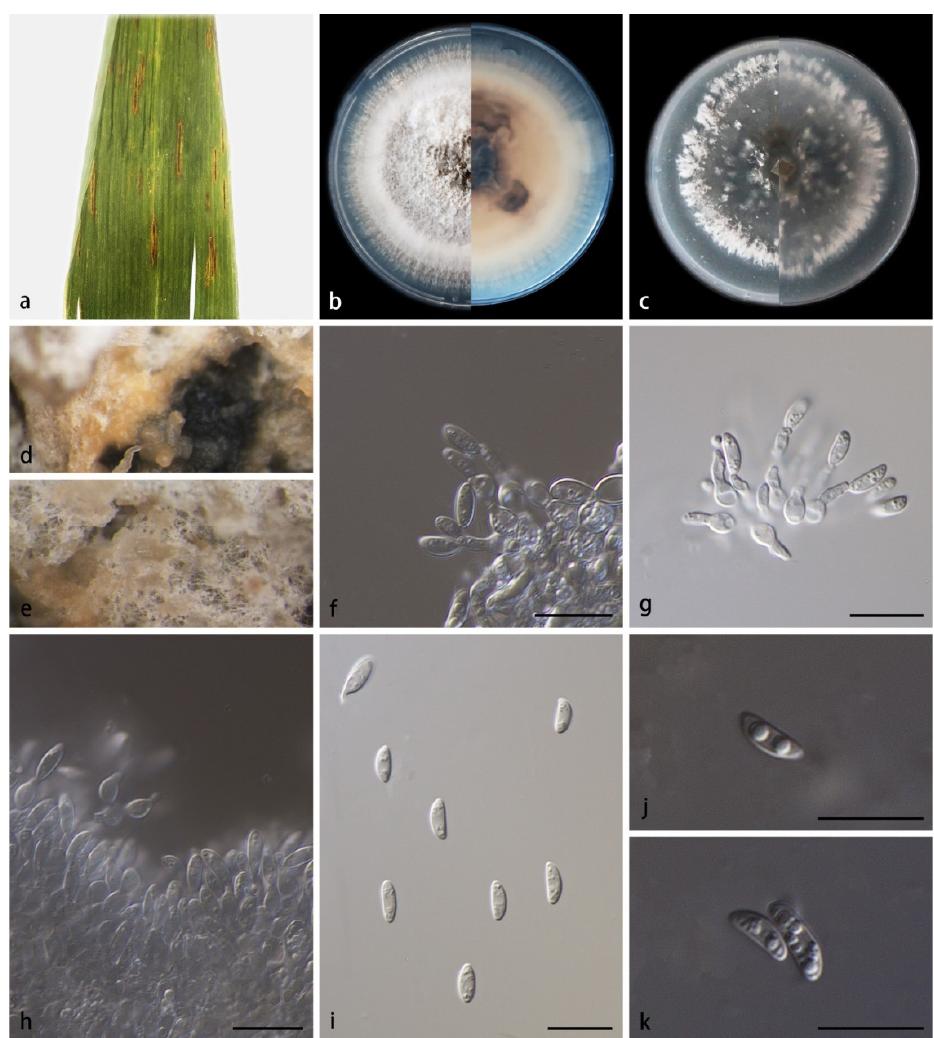
Figure 4. Microdochium hainanense (holotype HMAS352156, ex-holotype SAUCC210781). ( a ) leaves of host plant; ( b ) inverse and reverse sides of colony after 15 days on PDA; ( c ) inverse and reverse sides of colony after 15 days on OA; ( d ) sporodochia after removing the surface mycelia; ( e ) the mixture of conidia and secretions on mycelium; ( f – h ) conidiophores and conidiogenous cells; ( i – k ) conidia. Scale bars: ( f – k ) 10 µ